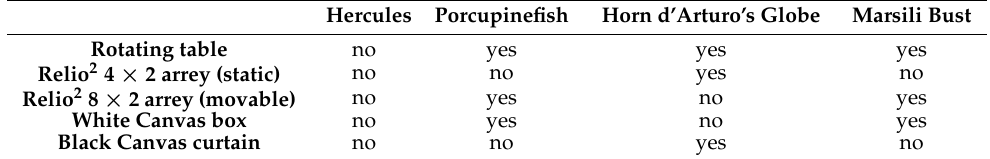
Table 4. The tools used in each case study.